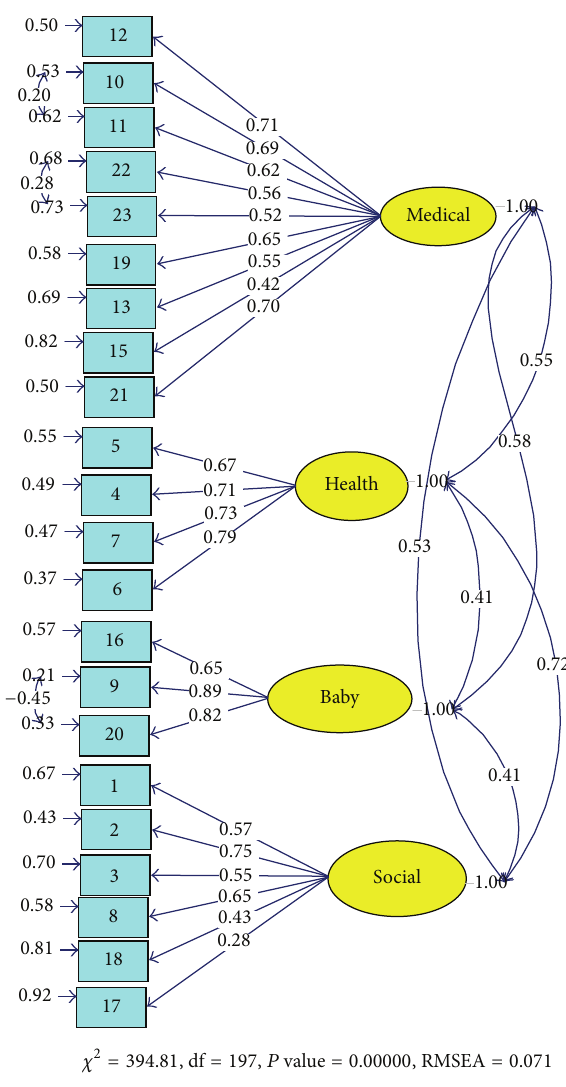
Figure 2: The results of CFA on the 22-item Cambridge Worry